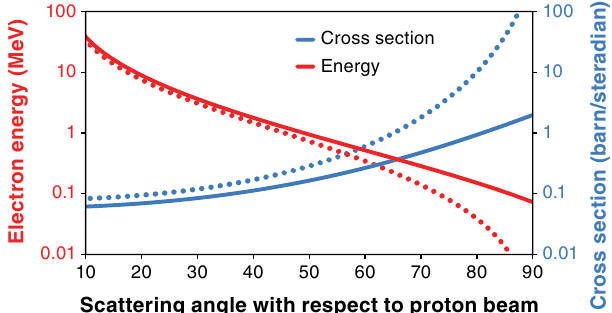
FIG. 1. The solid lines show calculated energies and approxi- mate scattering cross sections for 5 keV electrons backscattered by 250 GeV protons. The dotted lines correspond to the same quantities, but for 10 eV electrons as a qualitative indication of energetic electrons generated by the interaction of the beam with the residual gas and/or with low energy electrons captured in the potential well of the beam.